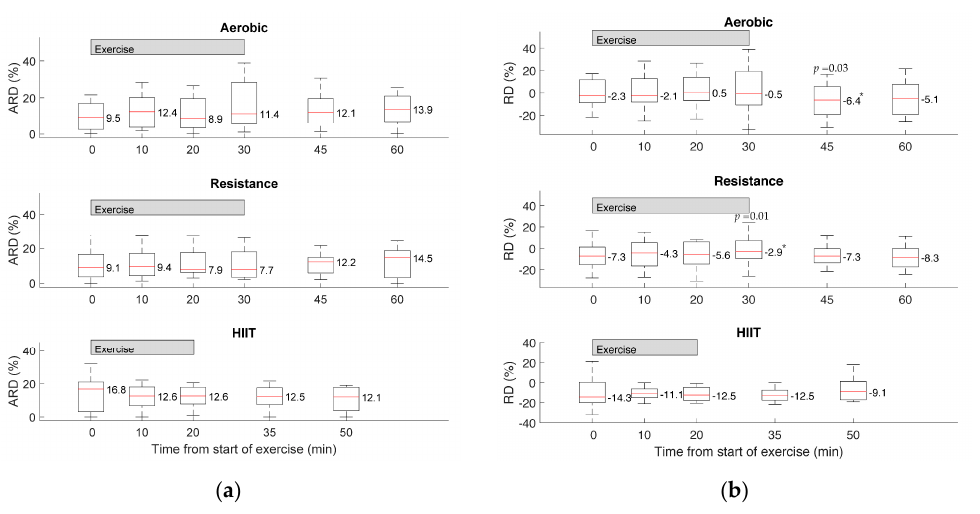
Figure 1. ( a ) Absolute relative di ff erences (ARD, %) and ( b ) relative di ff erences (RD, %) for aerobic, resistance and high intensity interval training (HIIT) exercise. Median values that are statistically significant from baseline are indicated by an asterisk (*), with the corresponding p -value listed